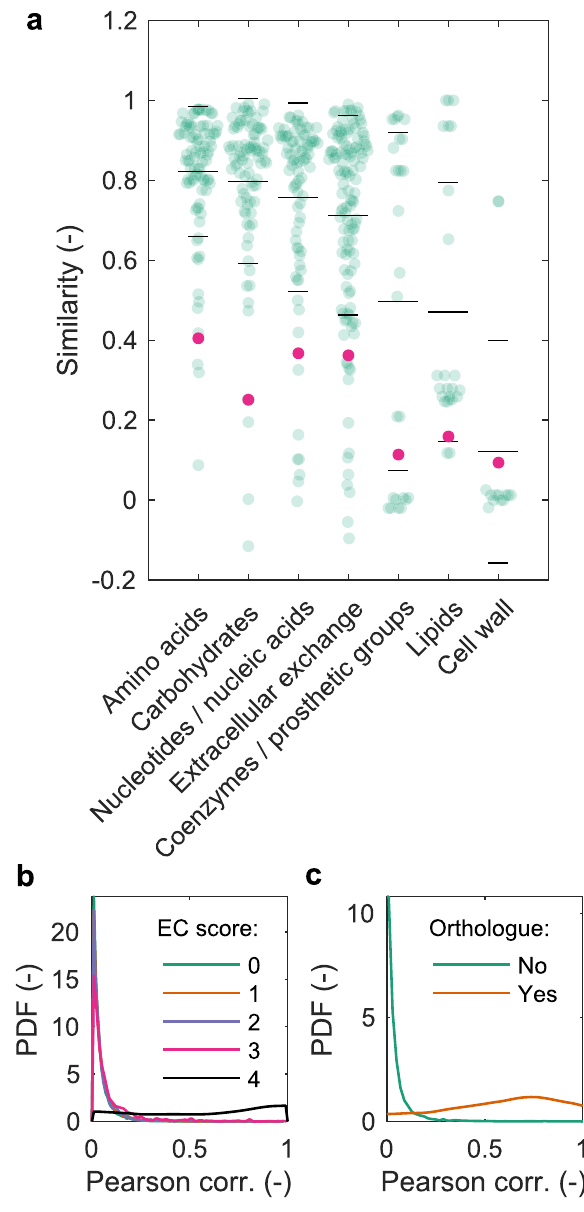
Fig.2|Predictionofsubsystemandgenefunctionality.a Sensitivitycorrelations (Pearson) of metabolic reactions (green) and corresponding Jaccard indices (pink) per subsystem (as de fi ned in the GSMs) in the E. coli and B. subtilis models. Long (short) horizontal black lines: mean (s.d.) per subsystem. Sensitivity similarities re fl ect gene similarities between human and yeast for Enzyme Commission (EC) numbers( b ;zero:nosimilarity;four:maximalsimilarity;notethatcurvesforscores zero to three overlay and are not distinguishable; for details, see Methods), and gene orthology ( c ; orthologous gene pairs from the OMA database 57